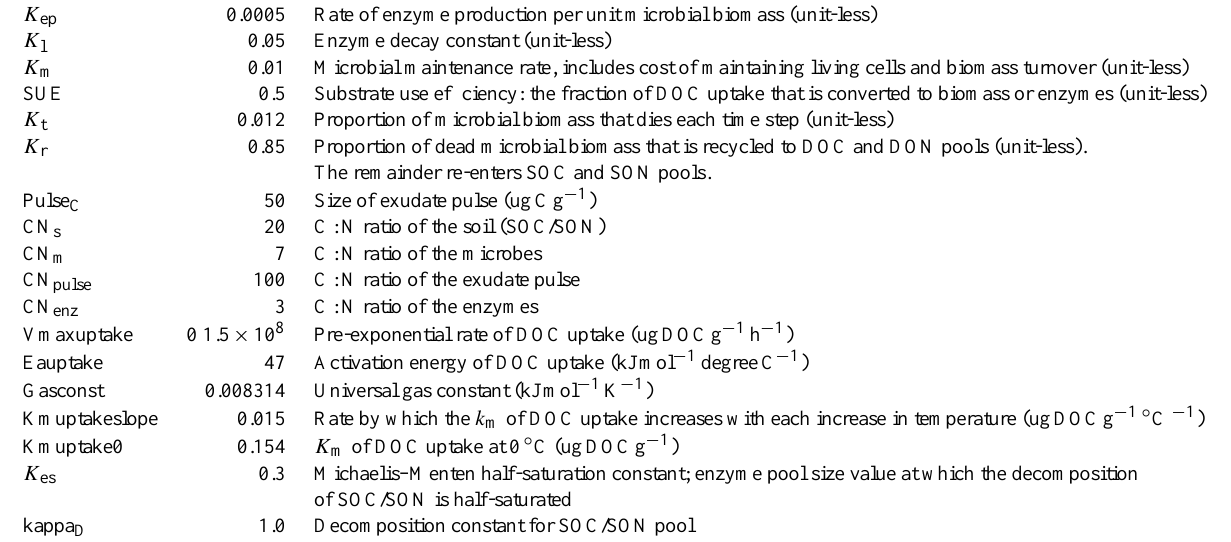
Michaelis–Menten half-saturation constant; enzyme pool size value at which the decomposition